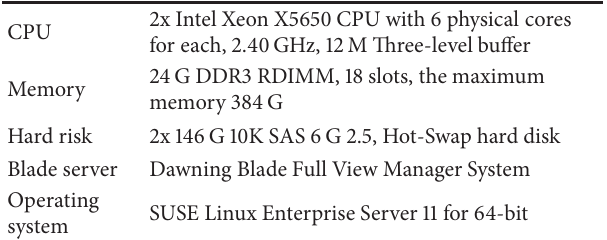
Table 1: The parameters of Blade High-Performance Computing Clusters